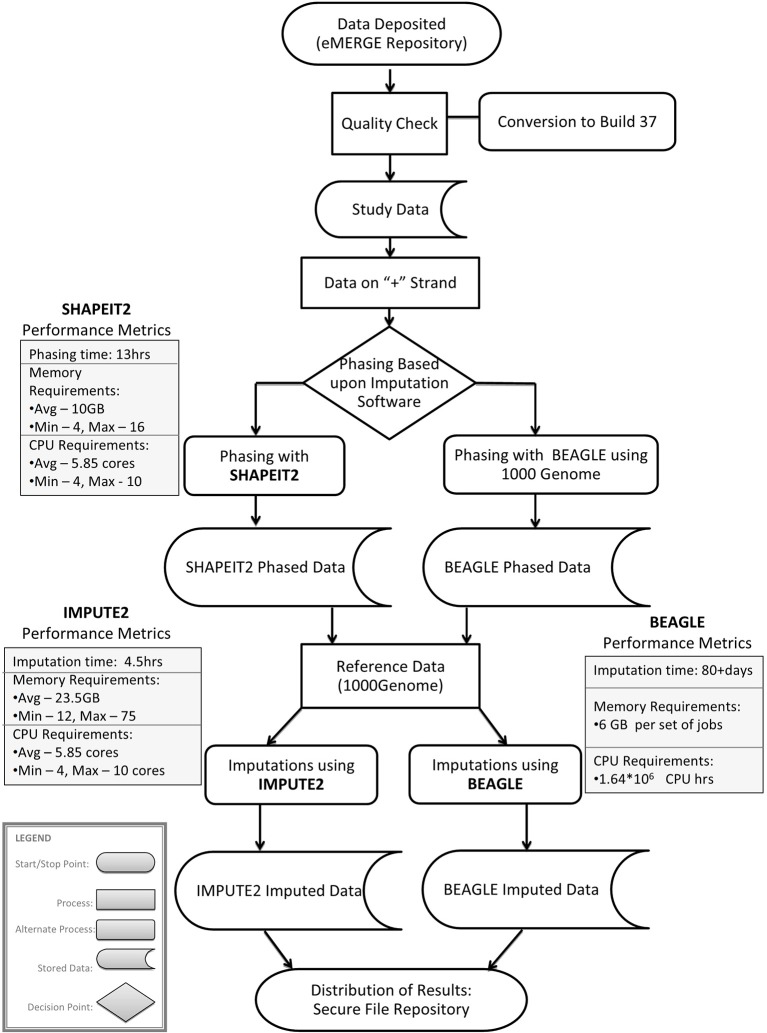
Workflow and performance metrics for imputation with BEAGLE and IMPUTE2.